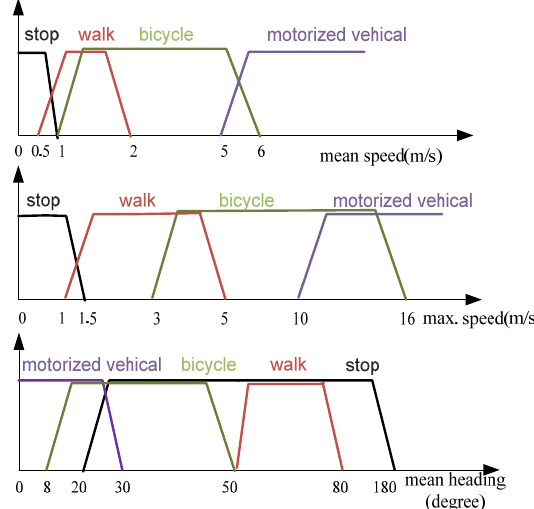
Figure 4. Value range of mean speed (top), maximum speed (middle), and mean heading changes (bottom) for different